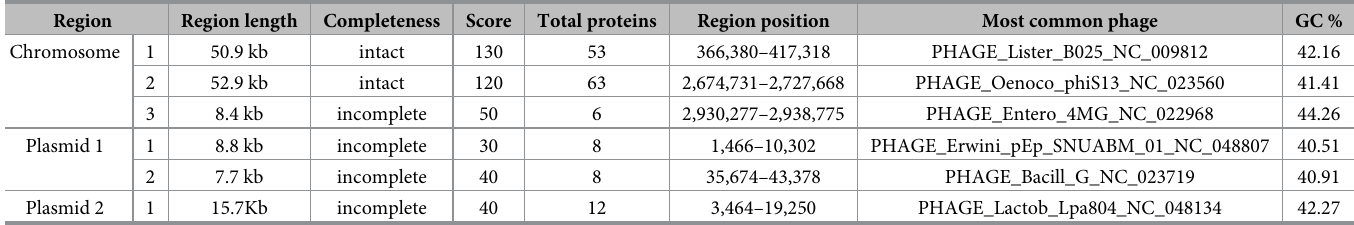
Table 5. List of prophage regions in the genome of Lactiplantibacillus plantarum PMO 08 predicted by PHASTER.